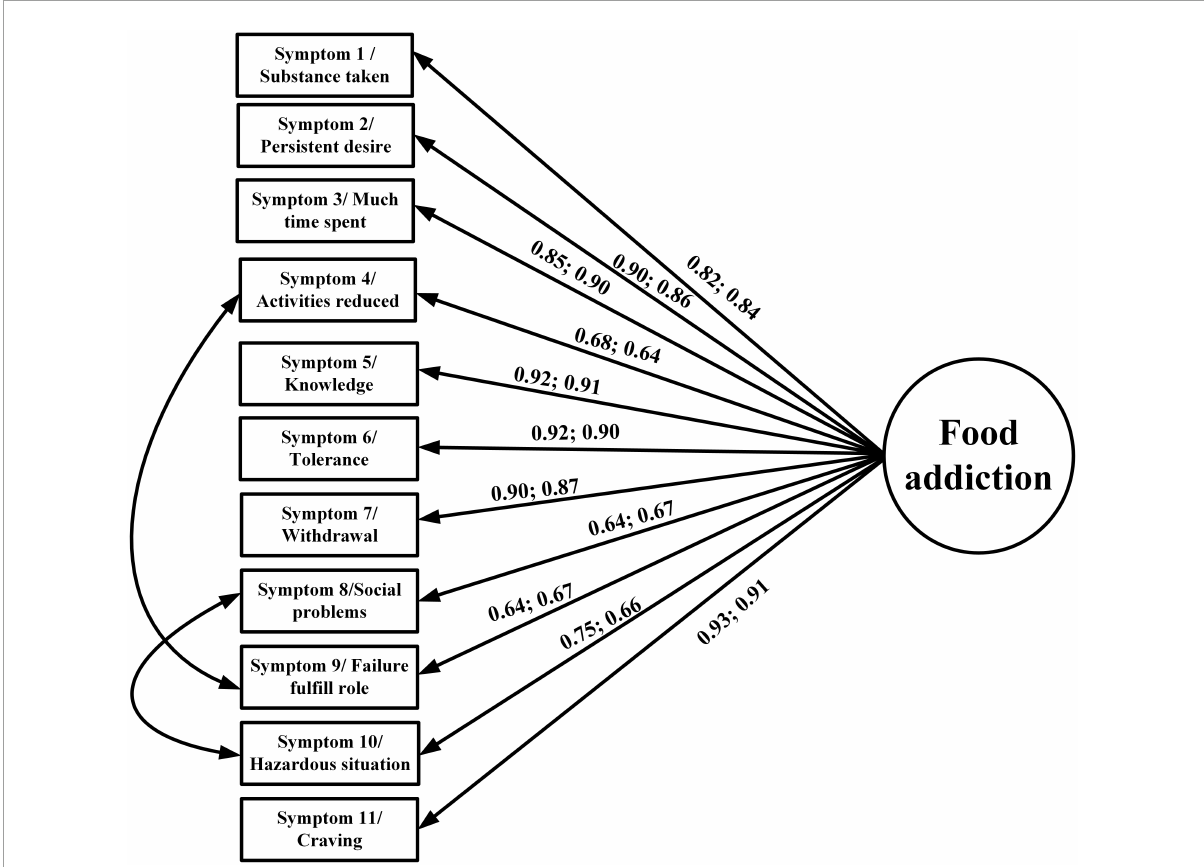
FIGURE1 Confirmatory factor analysis (CFA) to examine the first-order structure of the YFAS 2.0 and mYFAS 2.0. Data are presented as factor loadings (aka standardized coefficients) for each YFAS 2.0 and mYFAS 2.0 symptom item, which were all stronger than